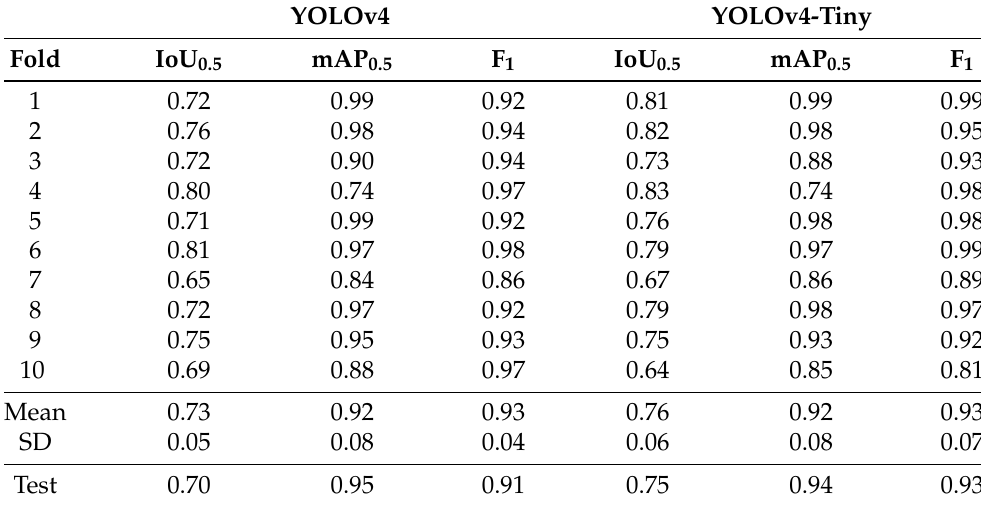
Table 3. Results of a patient-wise 10-fold CV.